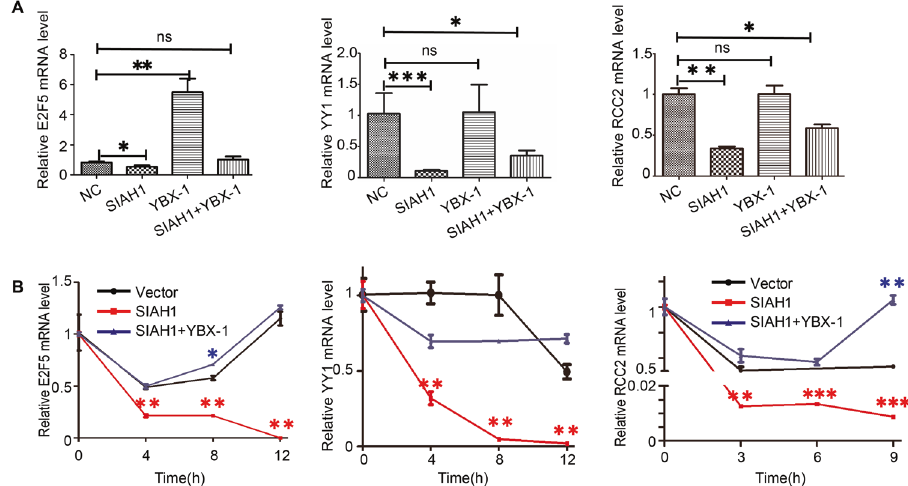
Fig. 8 SIAH1 indirectly regulates RNA stability through ubiquitinating YBX-1. A A2780 cells were transfected with Vector, SIAH1, YBX-1, and cotransfected with SIAH1 and YBX-1, respectively. qRT-PCR detected relative mRNA expression. B qRT-PCR detected the mRNA E2F5, YY1, and RCC2 expression of A2780 cells were transfected with Vector, SIAH1, and cotransfected with SIAH1 and YBX-1,